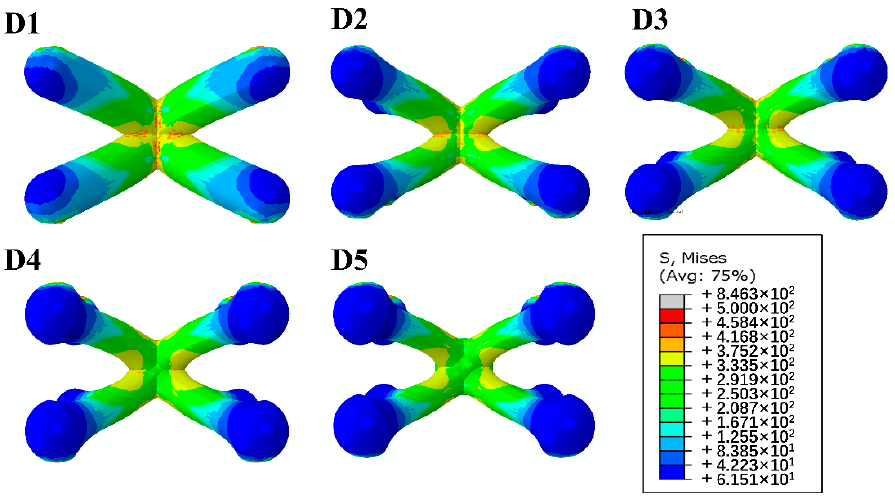
Figure 10. Mises stress distribution diagrams of a unit cell with different end diameters.